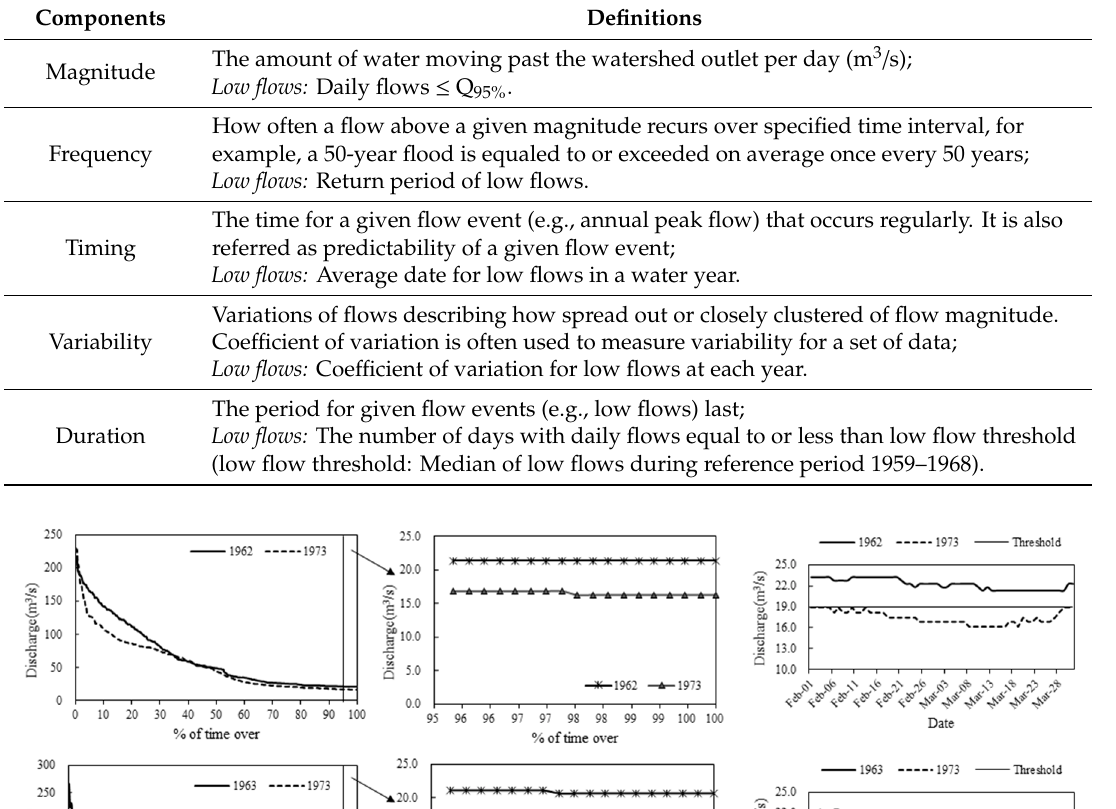
Table A1. Definitions for flow regime components [2].